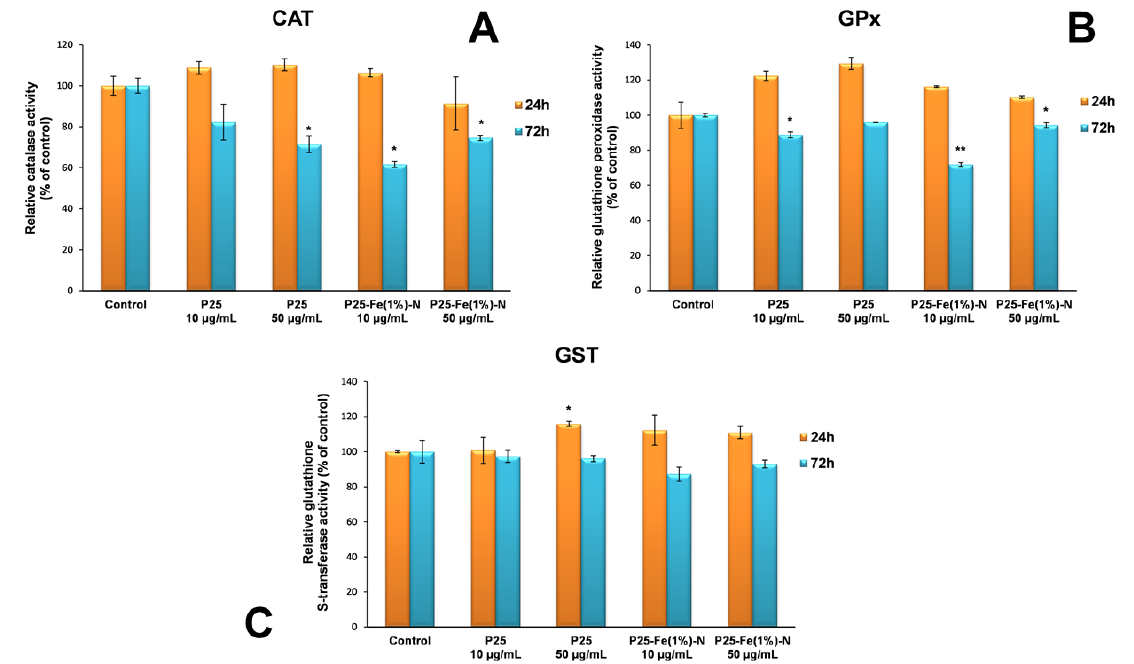
Figure 5. Relative levels of catalase ( A ) and glutathione-dependent enzymes (glutathione peroxidase and glutathione S-transferase) ( B , C ) specific activities in normal lung fibroblasts exposed to different concentrations (10 and 50 μg/mL) of the two TiO 2 NPs samples: P25 Degussa and P25-Fe(1%)-N for 24 h and 72 h. Results are expressed as means ± standard deviation (SD) ( n = 3) and represented relative to the untreated cells (control). * p < 0.05 and ** p < 0.01 compared to control.